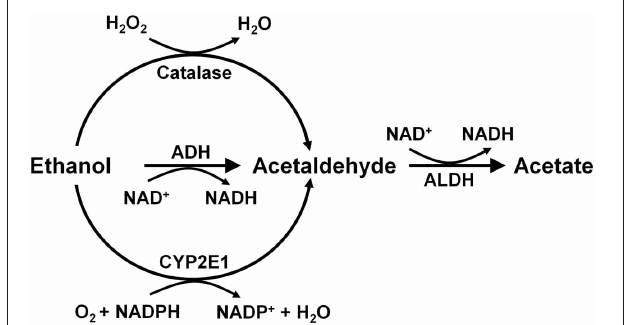
FIGURE 2 | Metabolismofethanolintoacetaldehydebythreeenzymatic systems. In the liver alcohol dehydrogenase(ADH) plays a major role, while catalase and cytochrome P450 (CYP2E1) play minor roles. In the brain, ADH (ADH1) is not expressed, but catalase mainly, and CYP2E1 to a minor extent, metabolize ethanol into acetaldehyde. Aldehyde dehydrogenase-2 (ALDH2) is present in virtually all cells (Drawn from Zimatkin et al., 2006).